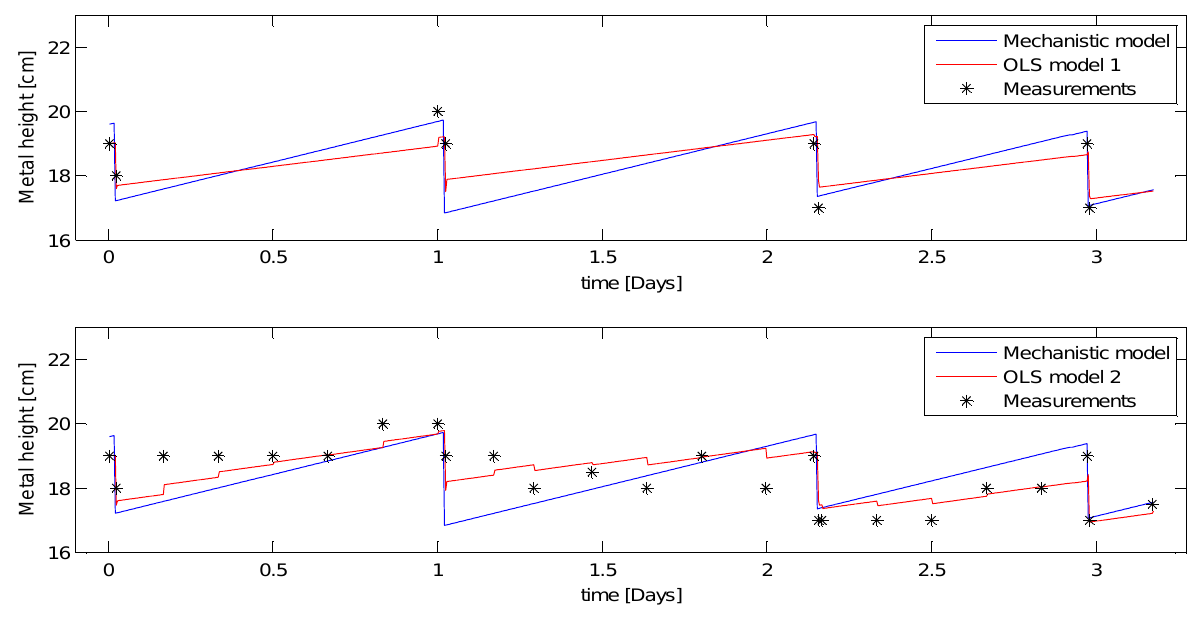
Figure 11: Predictions of the metal height, using two different OLS models based on the data from a real aluminium plant. OLS model 1 is based upon the measurements just before and just after the metal tap instants. OLS model 2 is in addition based on inter sampled measurements every 4 hour as indicated in the figure. The mechanistic model is based upon the physical parameters of the aluminium reduction cell, and the initial value is adjusted to fit the measurements. tion Analysis (CCA) initially developed by Hotelling was applied, to reduce the number of variables with poor correlation to the output. Running this test, all the 25 best correlation results were representing